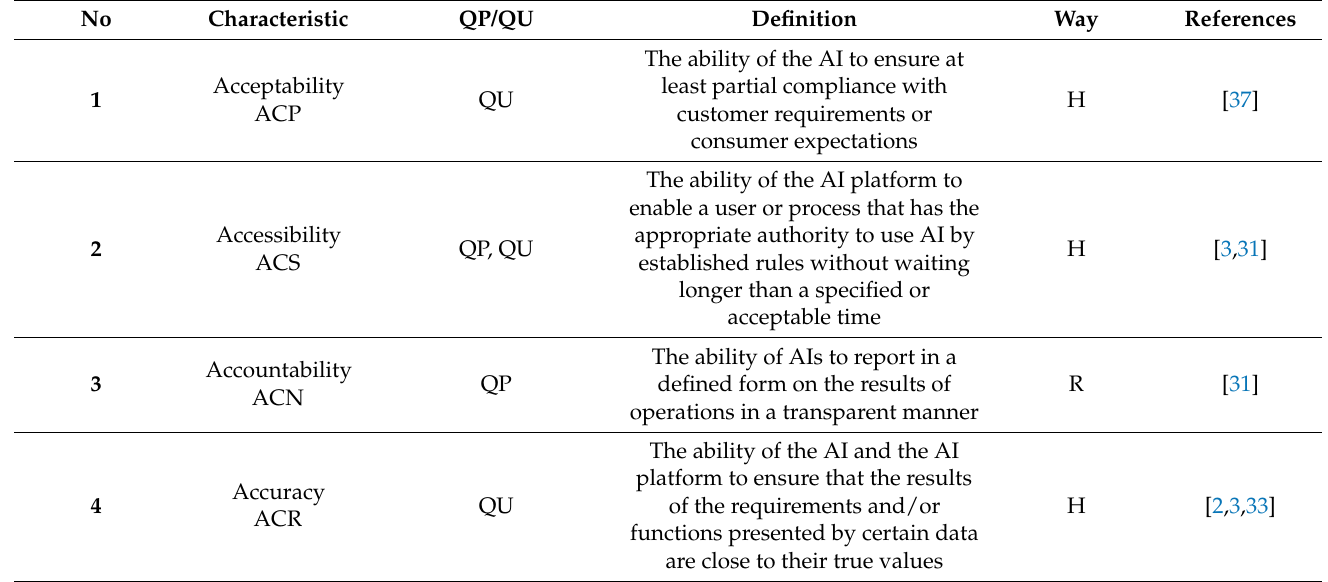
Table 3. Analysis of harmonization of AI characteristics